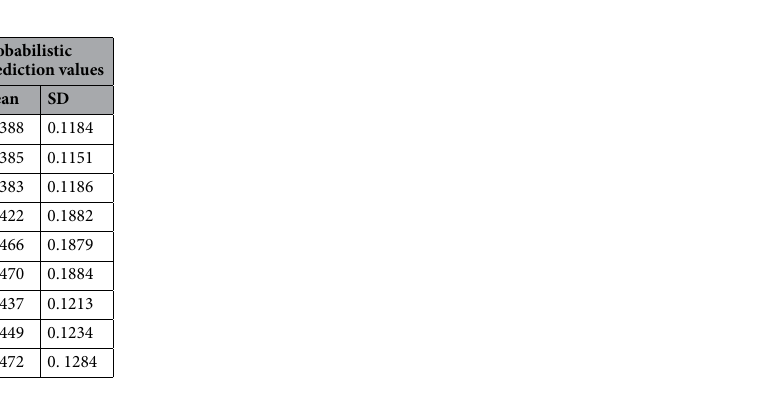
Table 4. Statistical characteristics of the probability values obtained from ME models. SD Standard